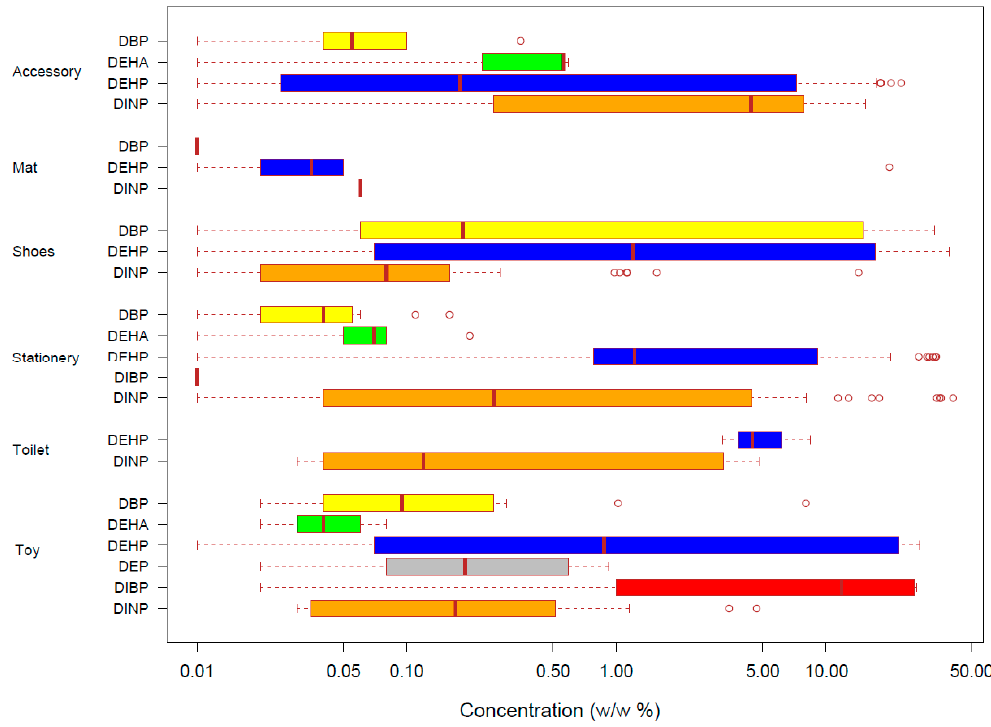
Figure 1. Range of plasticizers’ concentration in six categories of children’s products in which their concentration was above the detection limits. The box plot describes the minimum, 25 percentile, median, 75 percentile, and the maximum values, with outliers as open circles. Each chemical is expressed in different colors (DBP: yellow, DEHA: green, DEHP: blue, DEP: gray, DIBP: red, and DINP: orange).